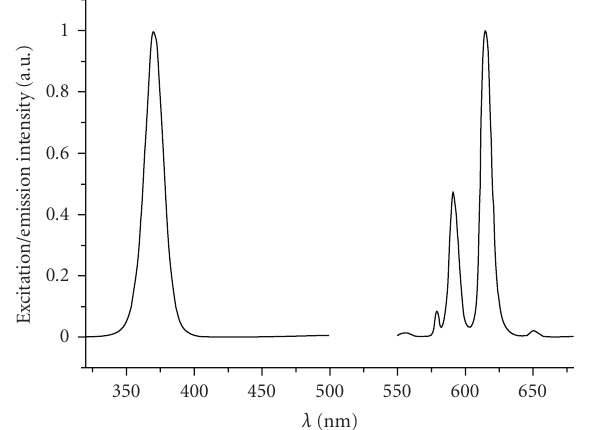
Figure 3: Normalized excitation and emission spectra of solid state (NO 3 )(H 2 O) complex (5 × 10 − 5 mol × dm − 3 ), λ exc = of Eu(C3CA) 2 2 365 nm.